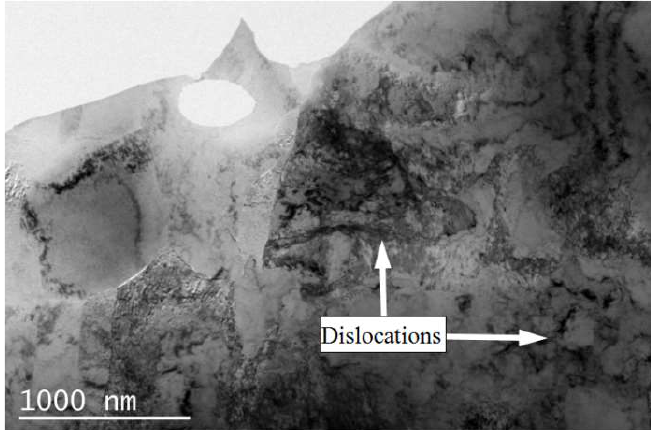
Figure 15. High-density dislocations of the rolled copper foil.